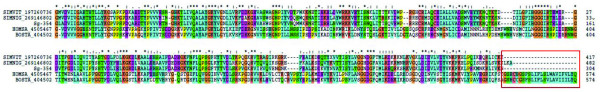
Clustal alignment of the carboxytermini of black fly salivary 5' nucleotidases/apyrase compared with mammalian enzymes. The Simulium guianense protein (Sg-354) and black fly homologs are compared with the human and bovine sequences. The box shows the deletion of the membrane anchor region in the salivary apyrases of black flies. The symbols above the alignment indicate (*) identical sites; (:) conserved sites, and (.) less-conserved sites. For other details, see Figure 3.